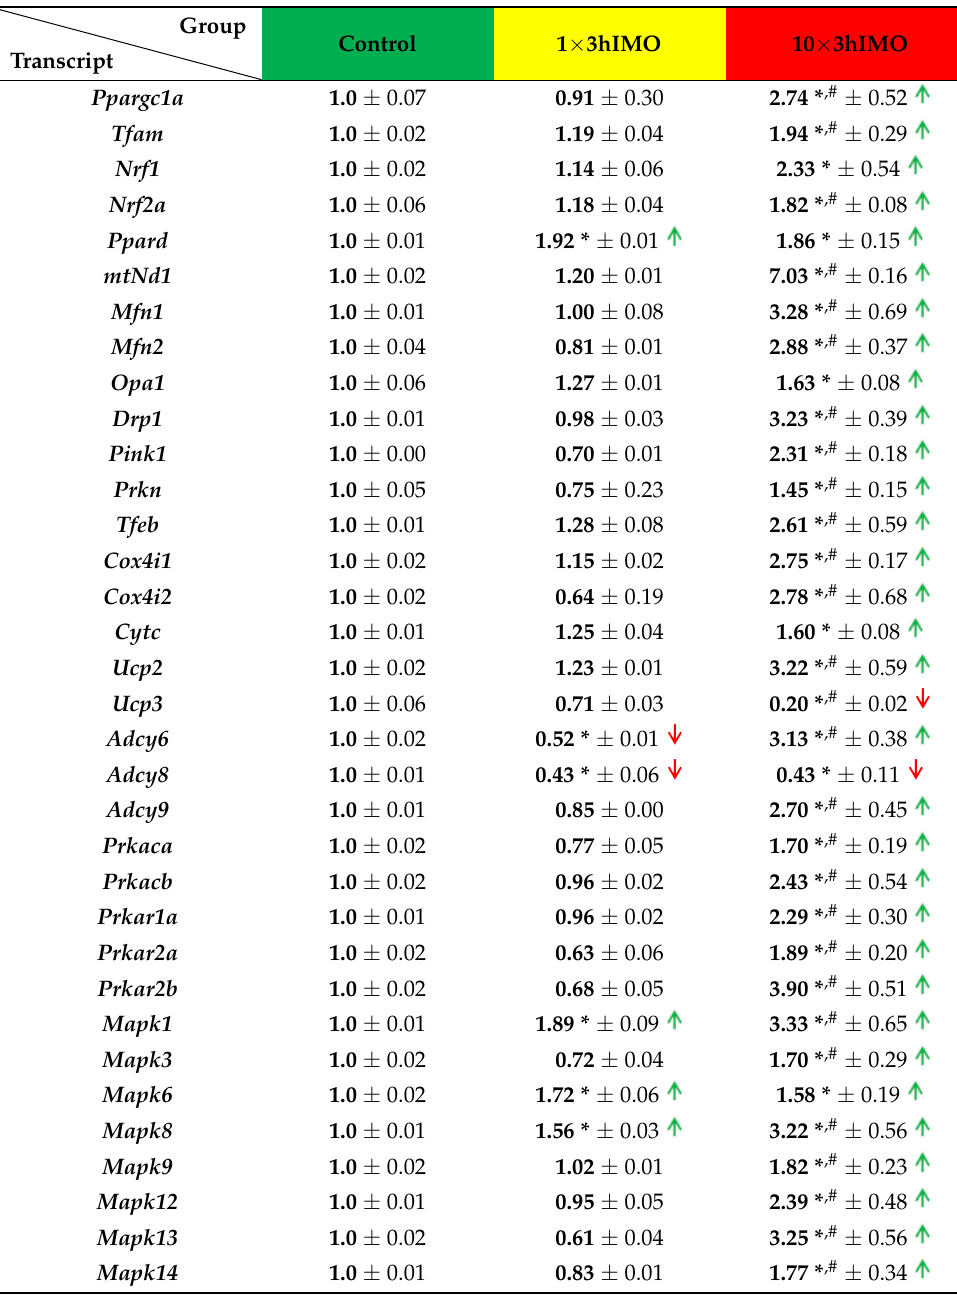
Table 1. The transcriptional profiles of mitochondrial dynamics and functionality markers and signaling molecules regulating mitochondrial dynamics and functionality as well as spermatozoa number and functionality are significantly changed in spermatozoa of repeatedly stressed adult rats. Data are presented as means ± SEM values of three independent experiments. Statistical